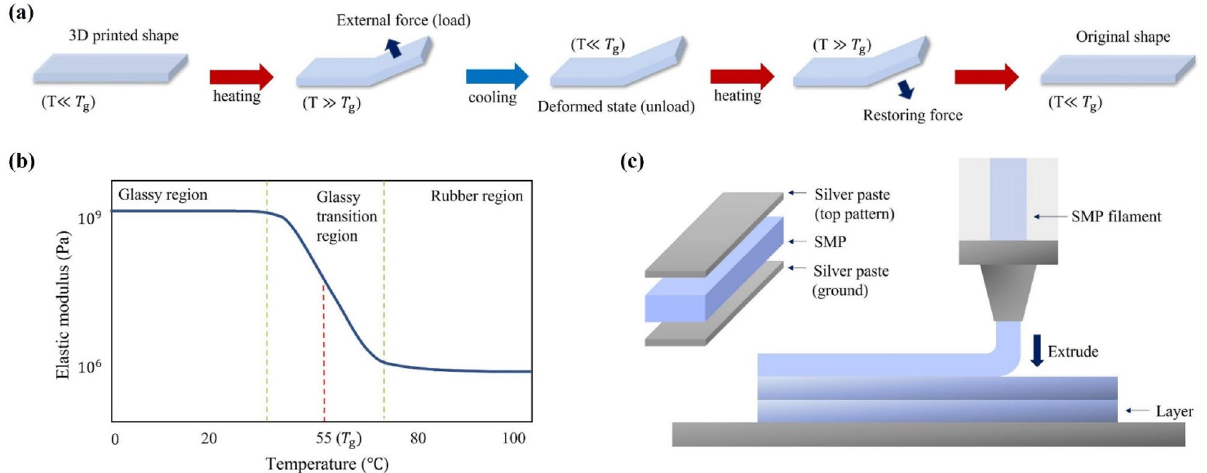
Figure 1. The mode of operation and production of an SMP structure. ( a ) A schematic of the transformation and recovery steps of an SMP structure. ( b ) Elastic modulus vs. temperature of the SMP filaments showing the glass-transition temperature ( T g ). ( c ) FDM 3D printing of the designed SMP-based spiral